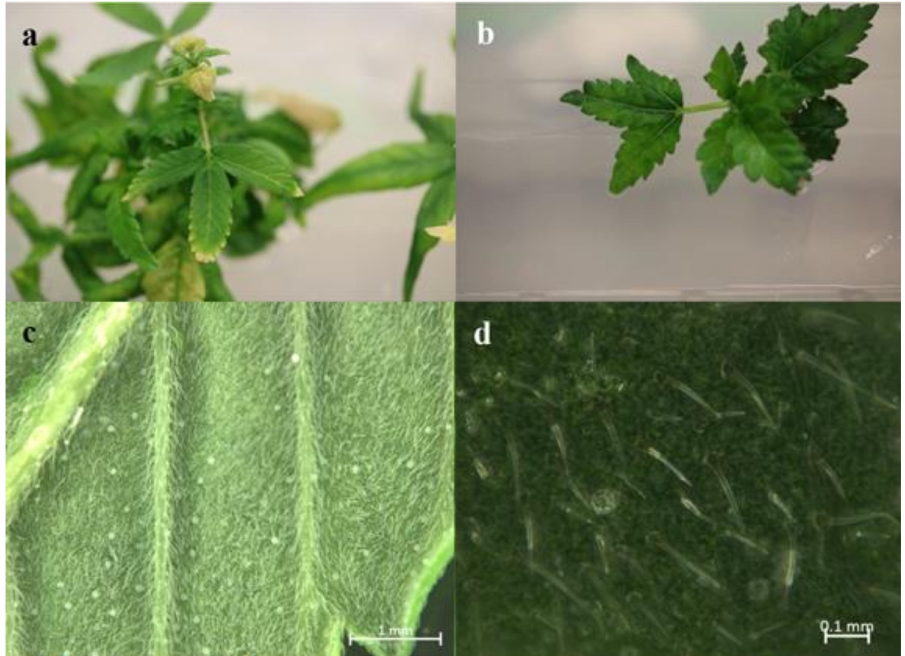
Figure 5. Comparing the morphological traits of diploid and tetraploid cannabis ( a ) Diploid Cannabis leaf, ( b ) Tetraploid Cannabis leaf, which is noticeably wider than the diploid, ( c ) Bright light image of diploid Cannabis stomata, ( d ) Bright light image of tetraploid Cannabis